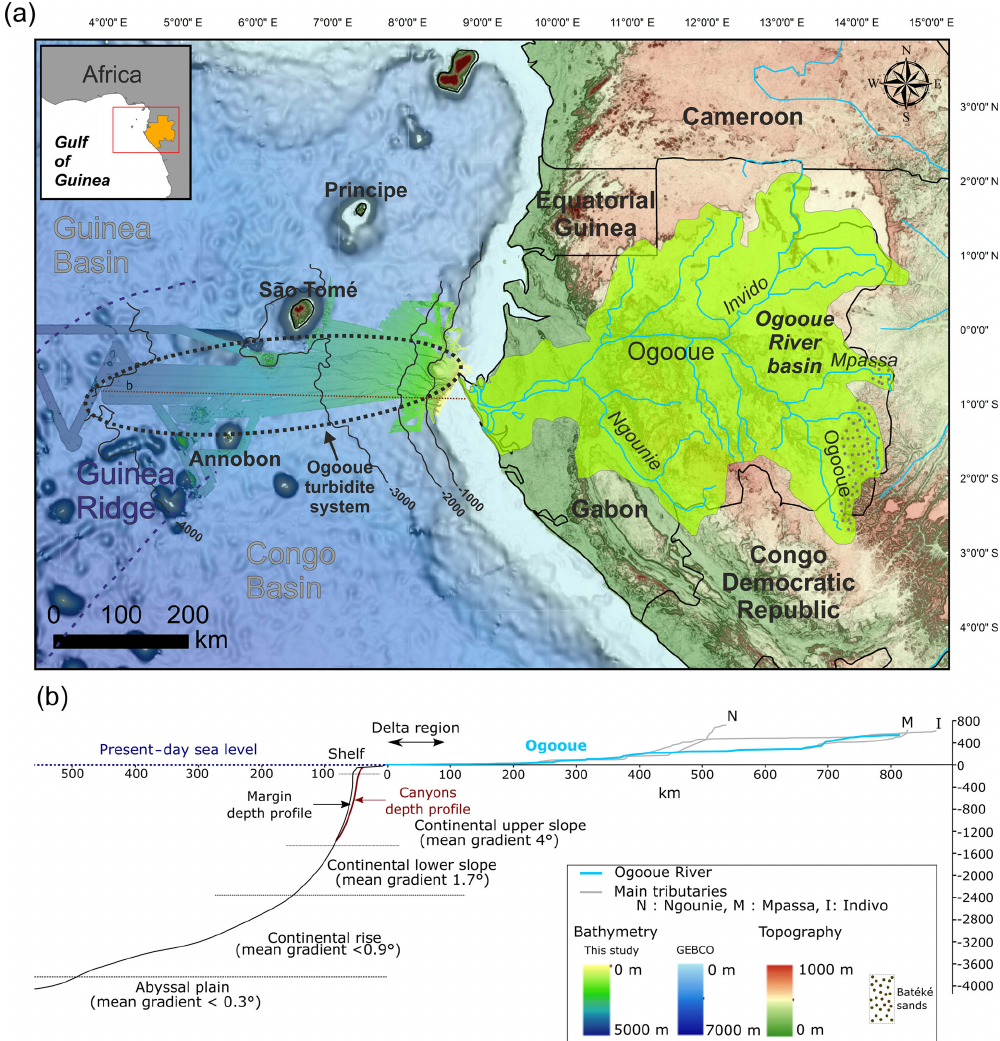
Figure 1. (a) The Ogooue sedimentary system from source (river and drainage basin) to sink (Quaternary turbidite fan). (b) Channel depth profile of the Ogooue River (blue) and its main tributaries (grey) and mean depth profile along the Gabonese